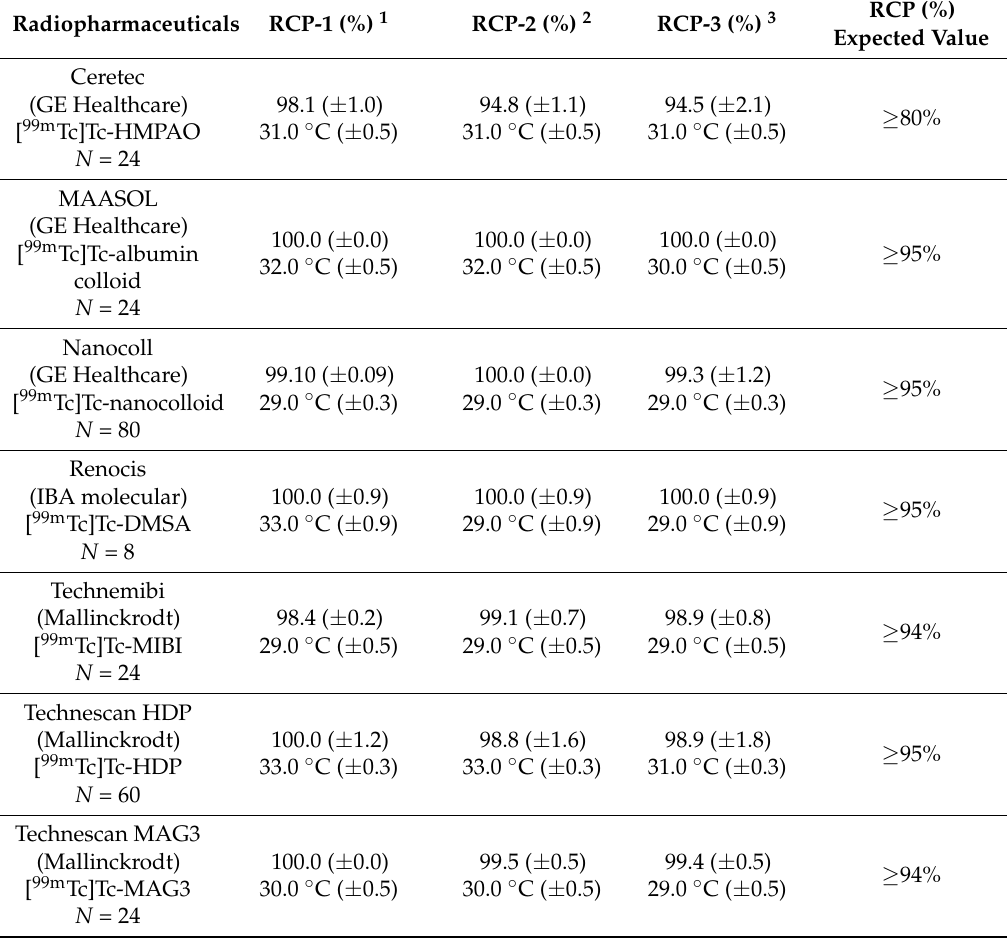
Table 4. RCP values expressed as % media ± SD and temperature values expressed as average ± standard